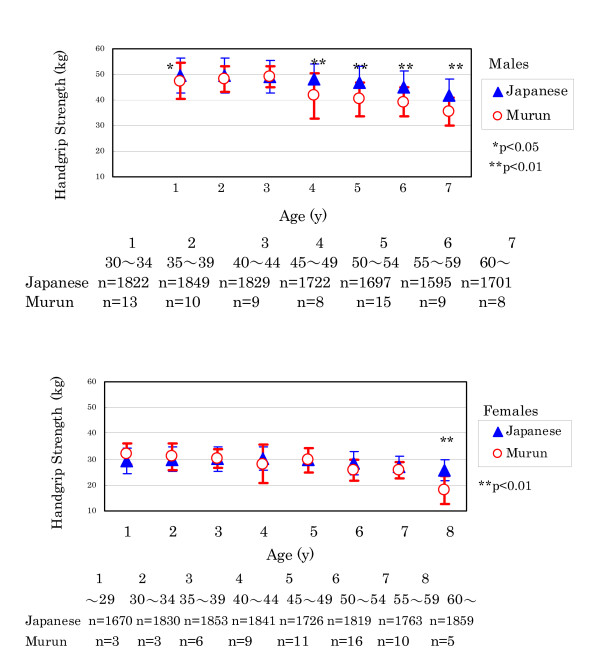
Comparison of handgrip strength between Murun subjects and Japanese people people. Handgrip strength of Murun subjects decreased earlier than that of age-matched Japanese. This finding suggests that ageing of Murun subjects may progress faster than that of Japanese people.